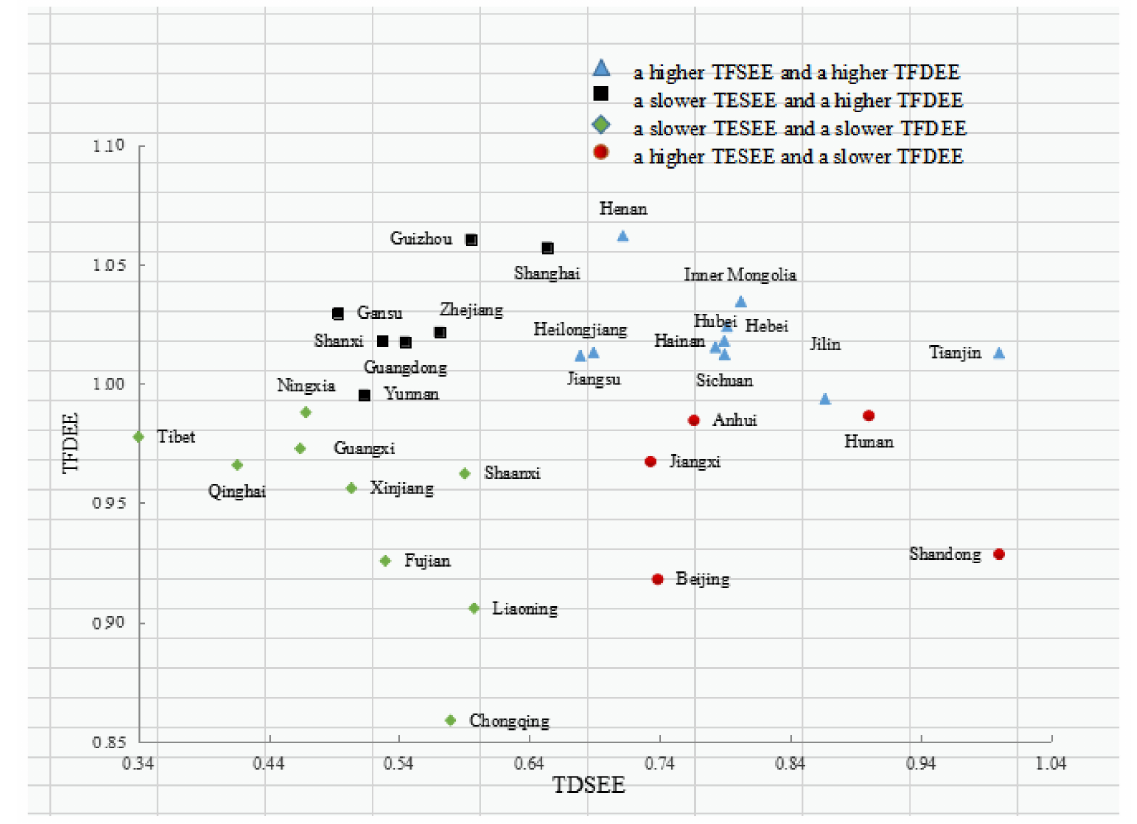
Figure 6. The advantages and disadvantages for improving environmental efficiency in China’s 31 provincial mining